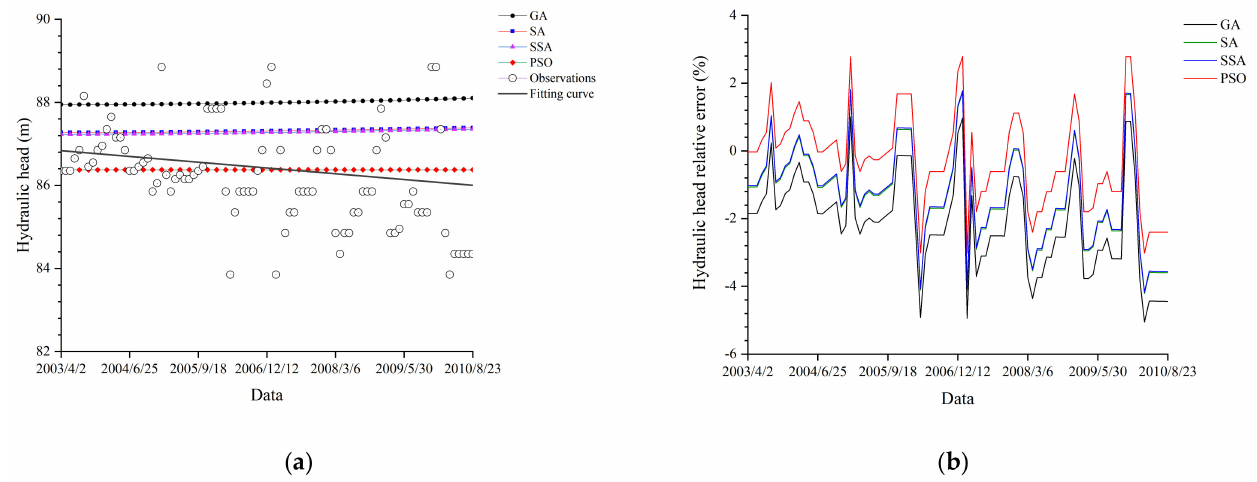
Figure 5. Comparison of measured and simulated values at piezometer P 9 ( b ) hydraulic head relative